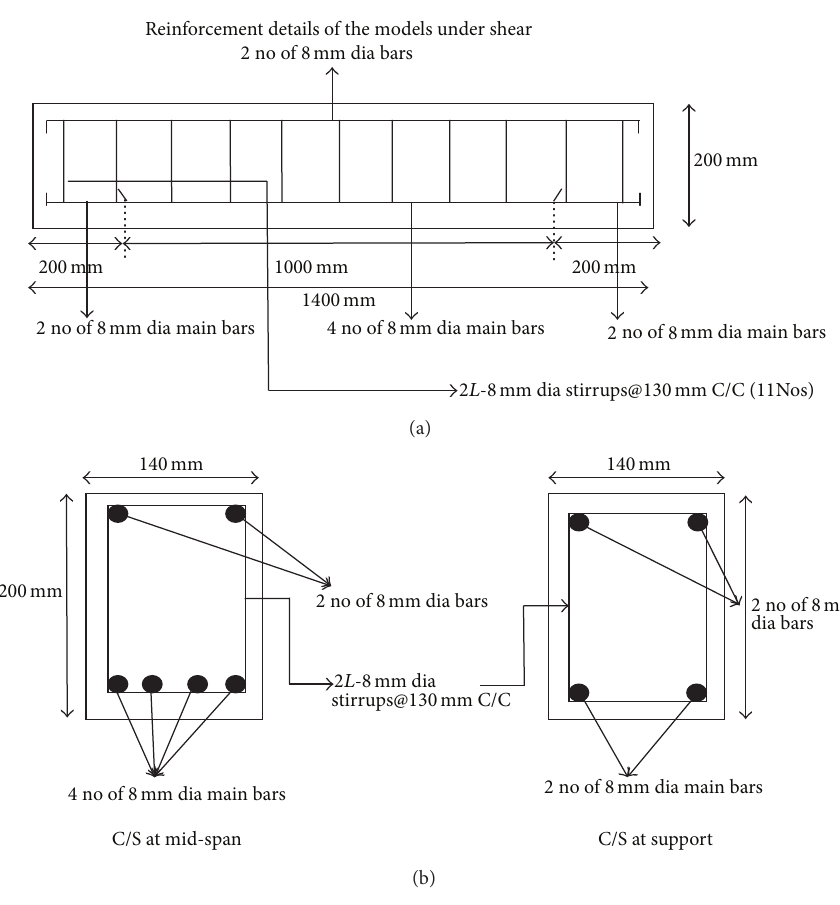
Figure 4: Reinforcement detailing of RCC beams (all sets, group A, B, and C). Table 2: Summary of test